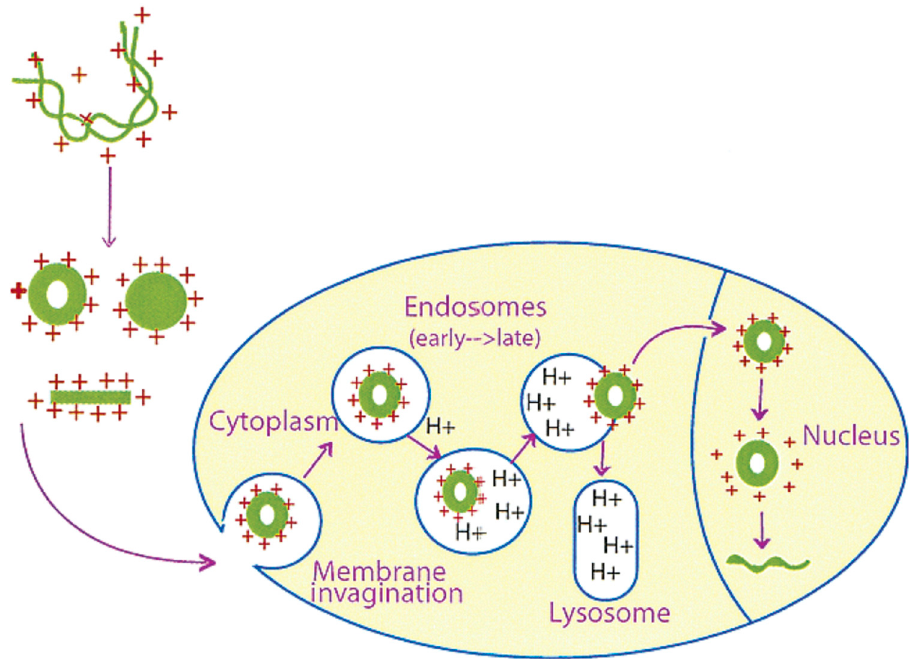
Figure 2. Schematic representation of DNA uptake by mammalian cells. DNA is compacted in the presence of polycations into ordered structures, such as toroids, rods, and spheroids. These particles interact with the anionic proteoglycans at the cell surface and are transported by endocytosis. The cationic agents accumulate in the acidic vesicles, increase the pH of the endosomes, and inhibit the degradation of DNA by lysosomal enzymes. They also sustain a proton influx, which destabilizes the endosome, and release DNA. The DNA then is translocated to the nucleus either through the nuclear pore or with the aid of nuclear localization signals, and decondenses after separation from the cationic delivery vehicle. Adapted with permission from Reference [9].